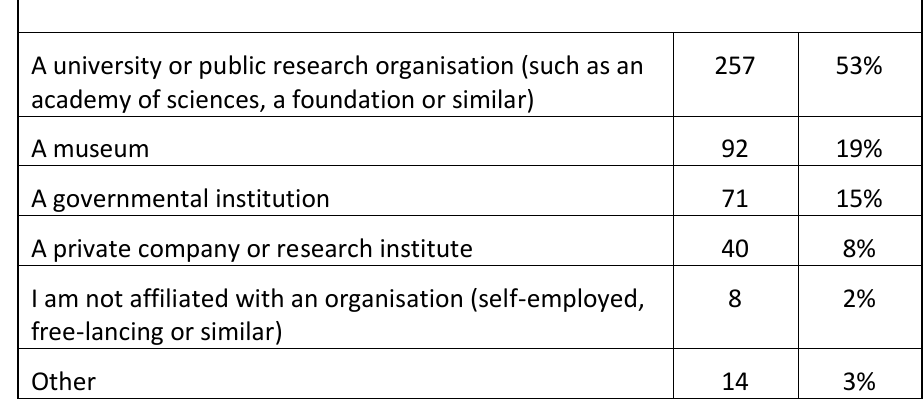
Table 3 : What type of organisation are you working for? ( N = 482)